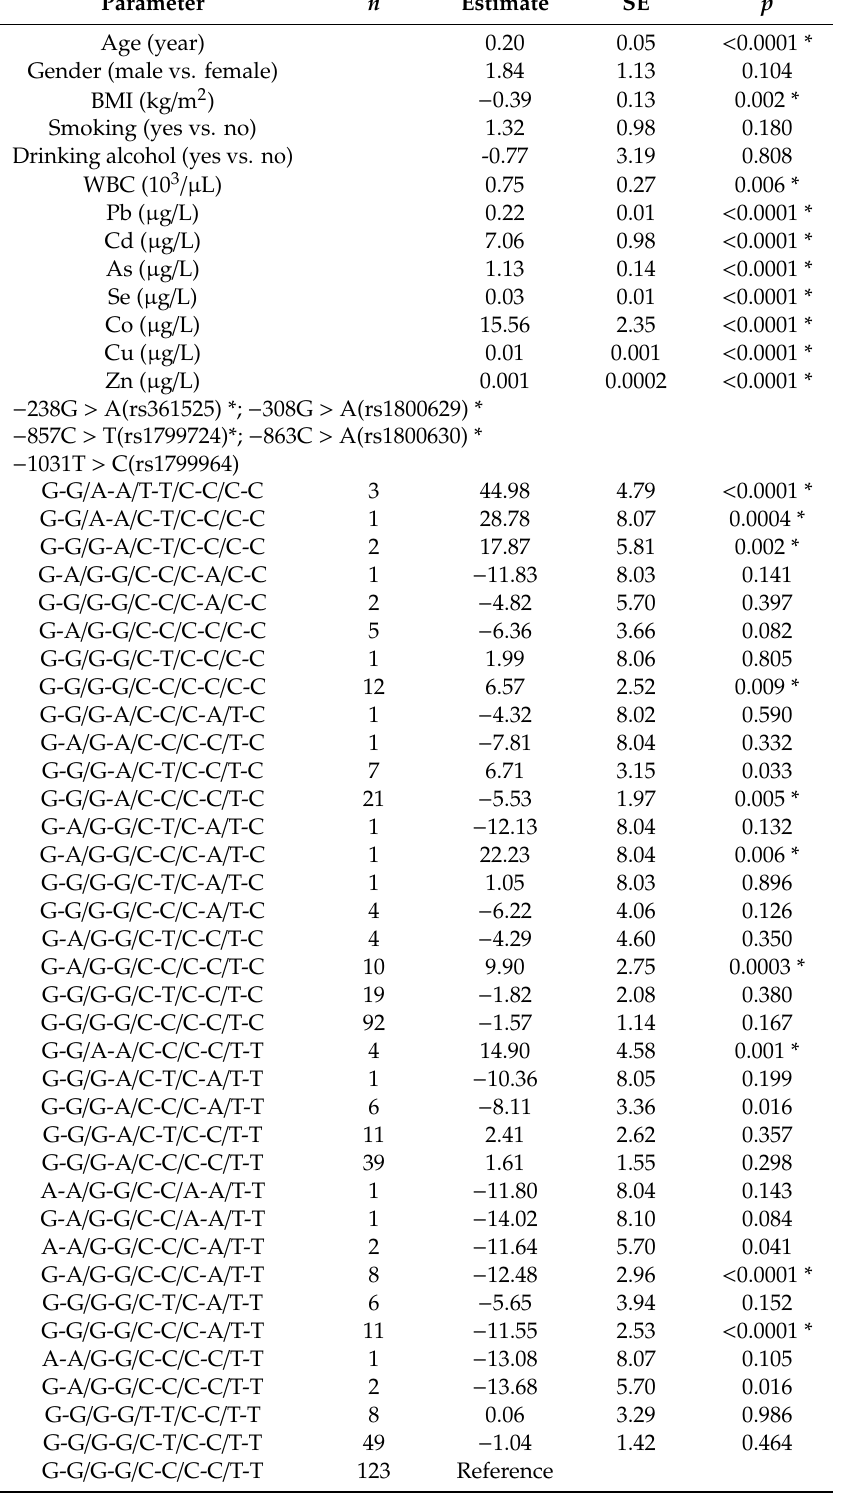
Table 4. Mixed-e ff ect model of the association of covariates and TNF- α SNPs with serum TNF- α level. Parameter n Estimate SE p Age (year) 0.20 0.05 < 0.0001 * Gender (male vs. female) 1.84 BMI (kg / m 2 ) Smoking (yes vs. no) Drinking alcohol (yes vs. no)